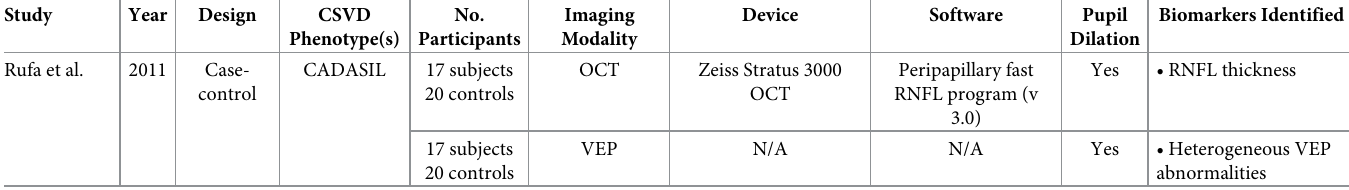
Abbreviations: CADASIL = Cerebral Autosomal Dominant Arteriopathy with Subcortical Infarcts and Leukoencephalopathy, CSVD = Cerebral Small Vessel Disease, ERG = Electroretinography, FA = Fluorescein Angiography, OCT = Optical Coherence Tomography, OCTA = Optical Coherence Tomography Angiography, OP = Oscillatory Potentials, PERG = Pattern Electroretinography, RNFL = Retinal Nerve Fiber Layer, VEP = Visual Evoked Potentials, WMH = White Matter